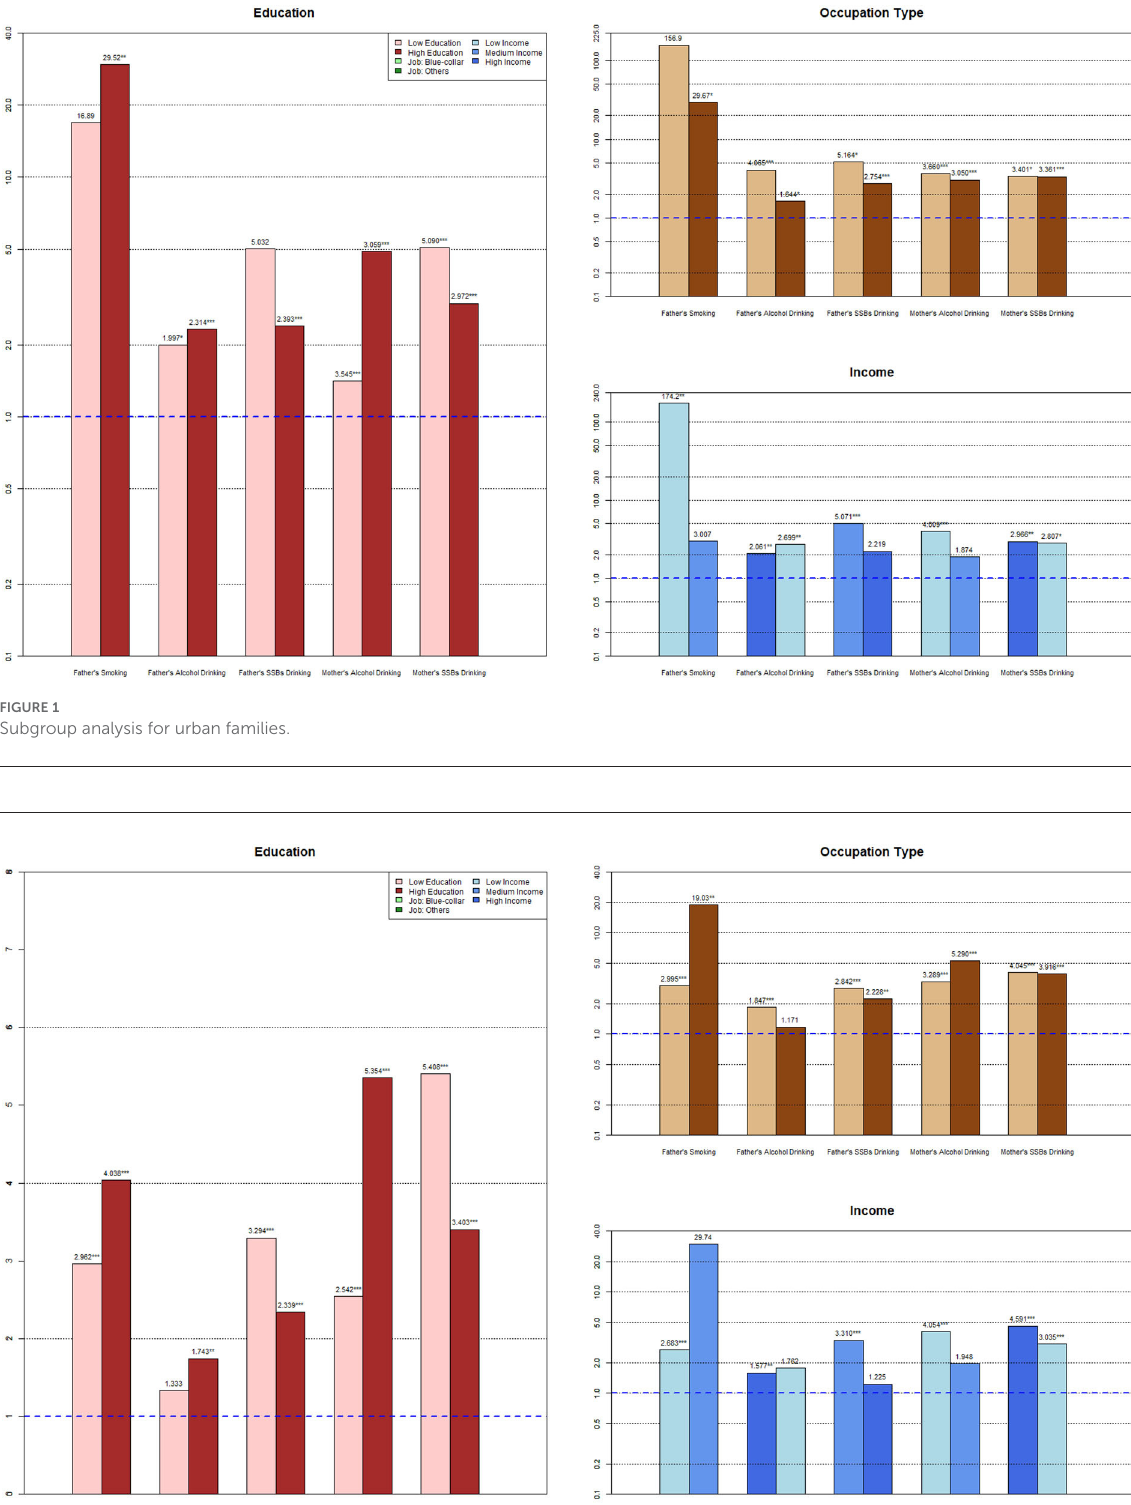
FIGURE2 Subgroup analysis for rural